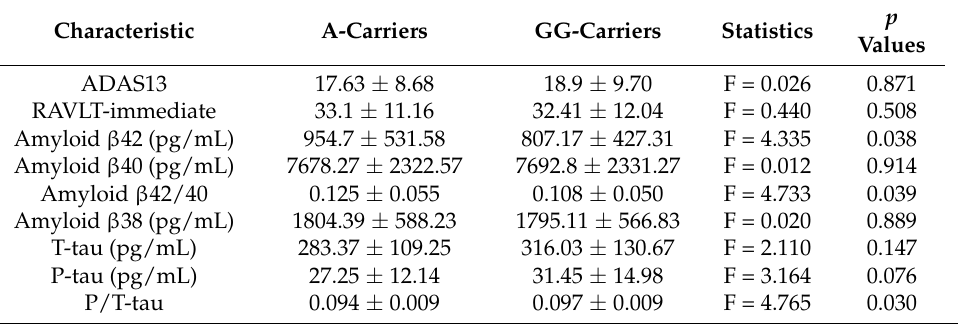
Table 4. Main effects of PICALM on neuropsychological tests, amyloid β , and